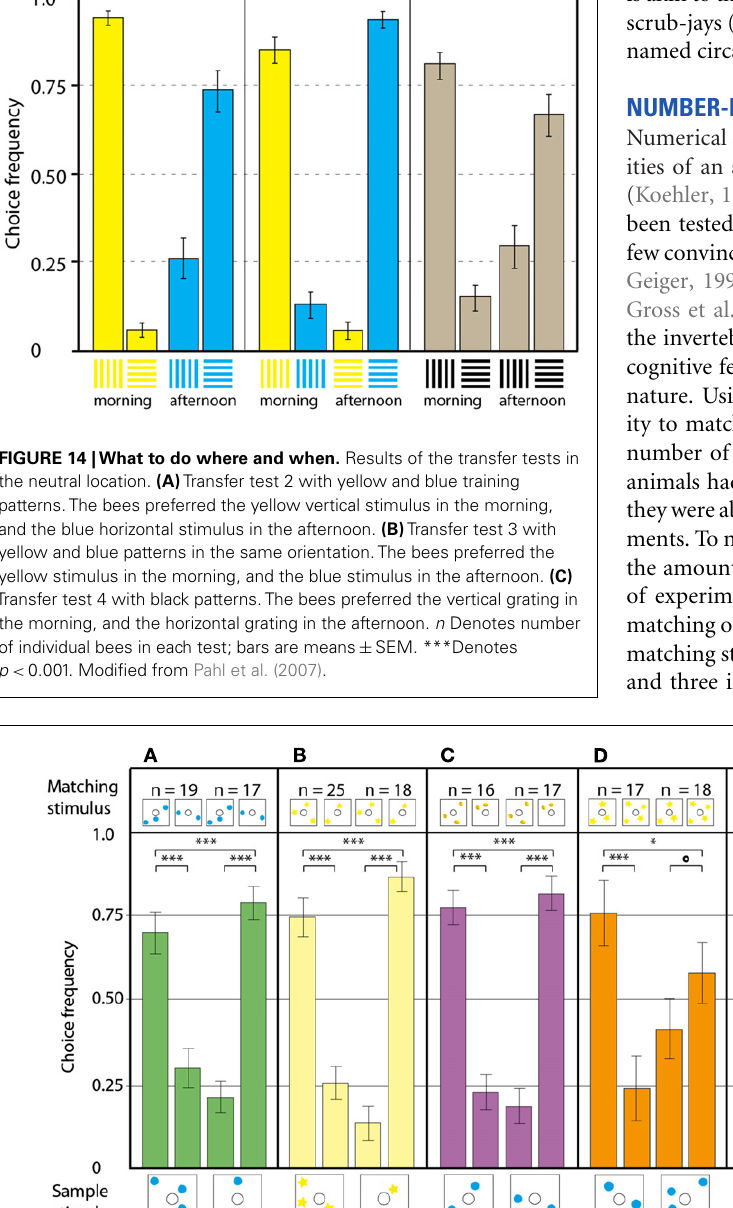
choice stimuli are composed of two different elements. (D–F) Bees trained to discriminate between two and three are tested on stimuli with (D) three and four elements, (E) four and five elements, (F) five and six elements, (G) four and six elements. n , Number of bees per condition. Error bars show standard error. ***Denotes statistically significant difference at p < 0.001, **Denotes p < 0.01, *denotes p < 0.05, and O denotes p > 0.05. Modified from Gross et al.